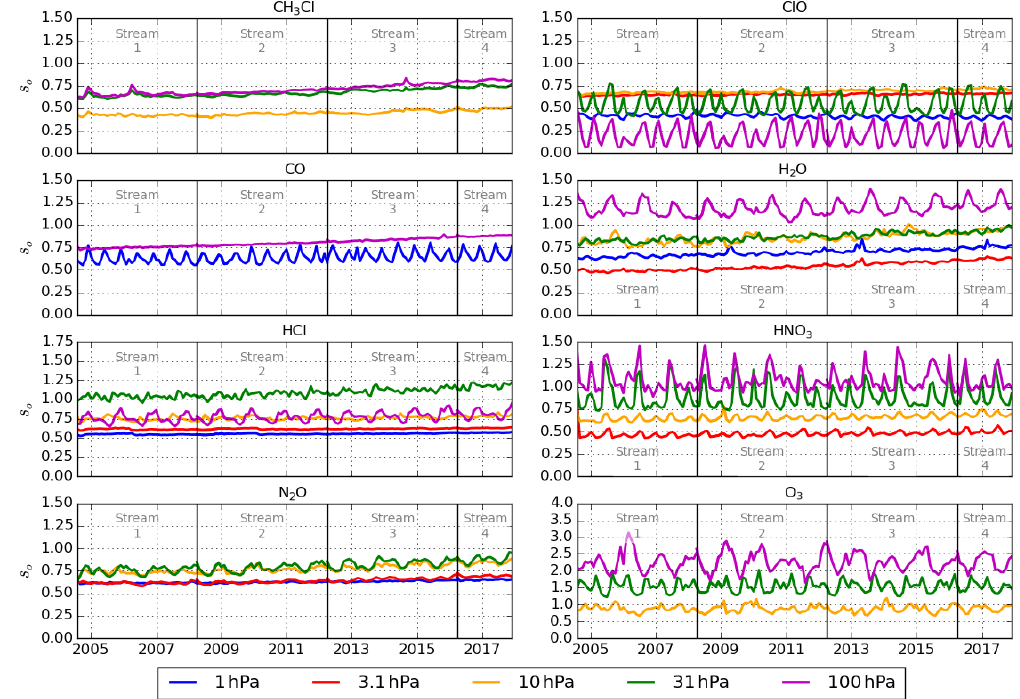
Figure 2. Time series of monthly mean observational error scaling factors s o for each assimilated species at five specific MLS levels: 1, 3.1, 10, 31 and 100hPa. The vertical black lines show the dates of the transition between the different